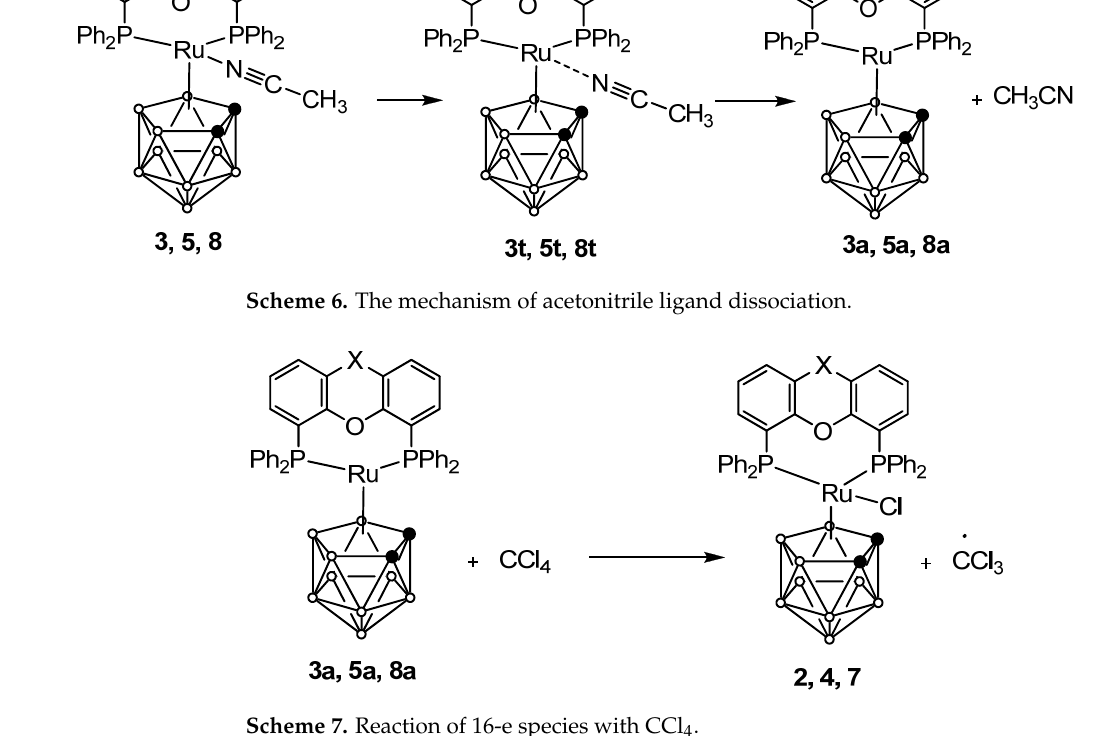
Table 4. The calculated energy changes for the reactions depicted on Schemes 6 (I) and 7 (II).